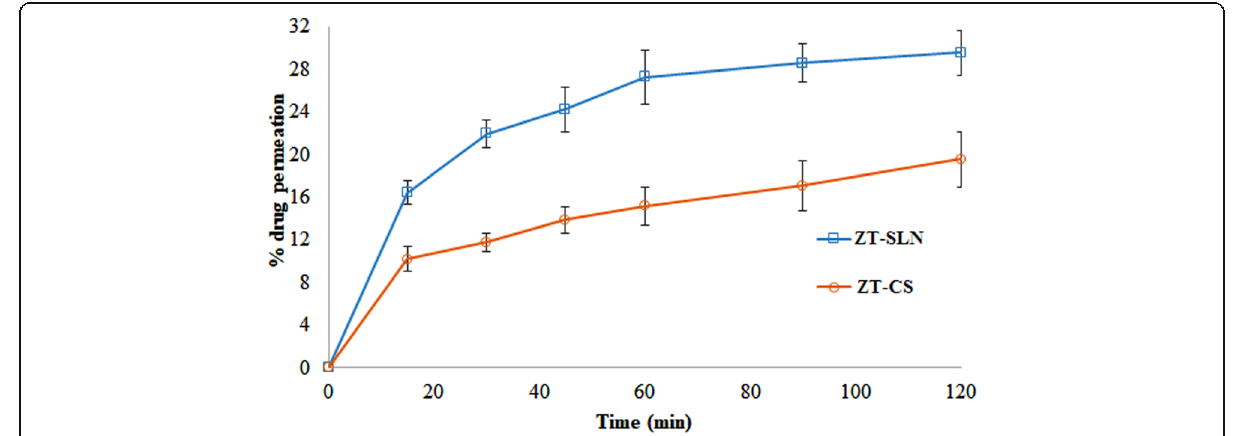
Fig. 2 Ex vivo permeation profiles of zotepine from ZT-CS (F7) and ZT-SLN (F1) formulations (mean ± SD, n =